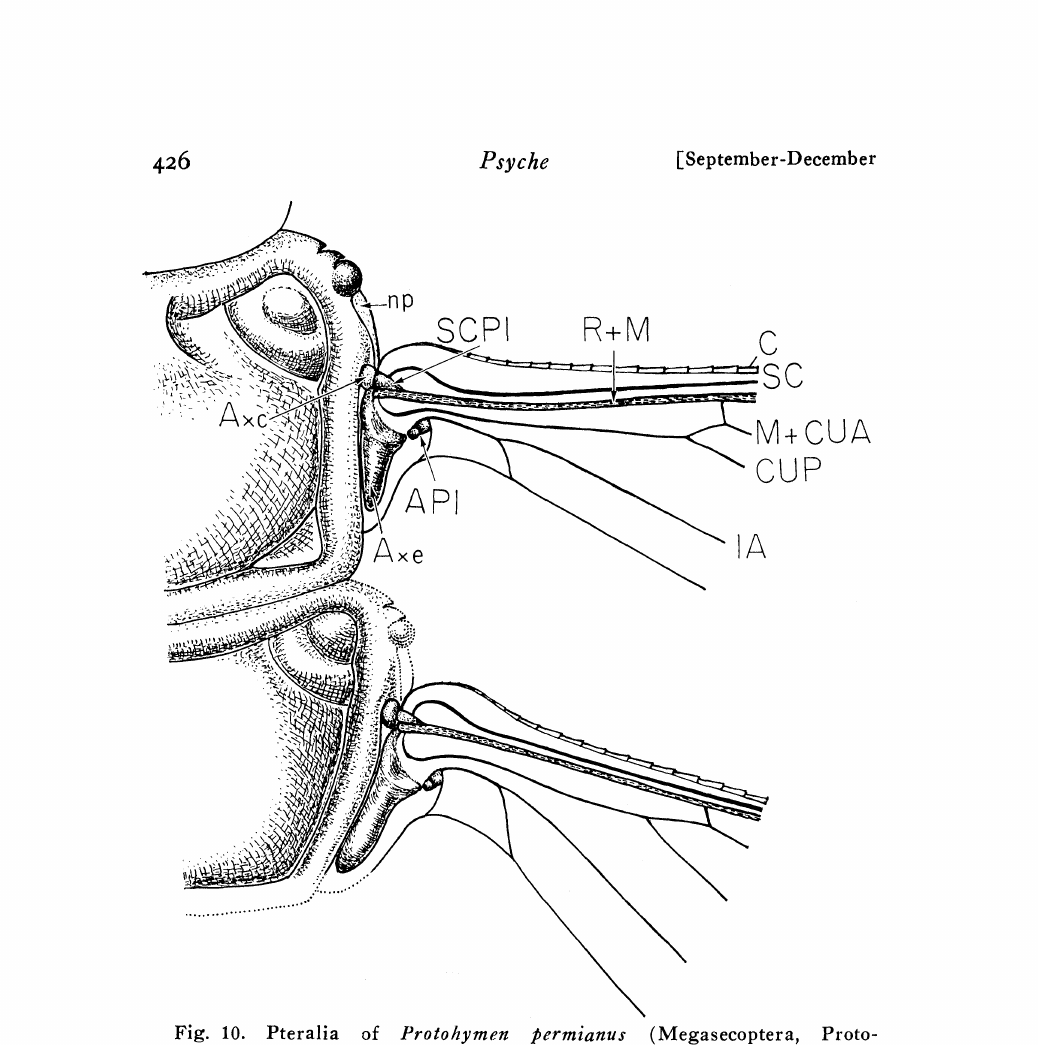
Fig. 10. Pteralia of Protohymen permianus (Megasecoptera, Proto- hymenidae). Enlarged base of the fore and hind wings. Original. API anal plate; Axe--convex axillary selerite; Axe--- elongated axillary selerite; rip---narrow plate; SeP1 subeostal plate. Lower Permian,